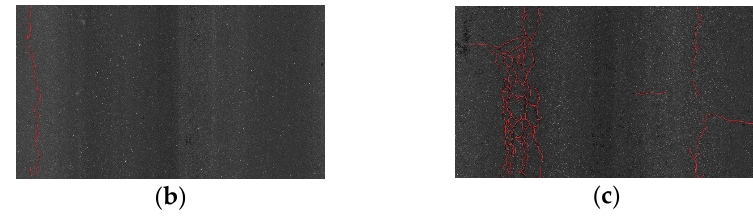
Figure 21. Diagram of crack disease sample: ( a ) Transverse crack; ( b ) Longitudinal crack; ( c ) Map crack. Table 5. Distribution of training samples for each type of disease.